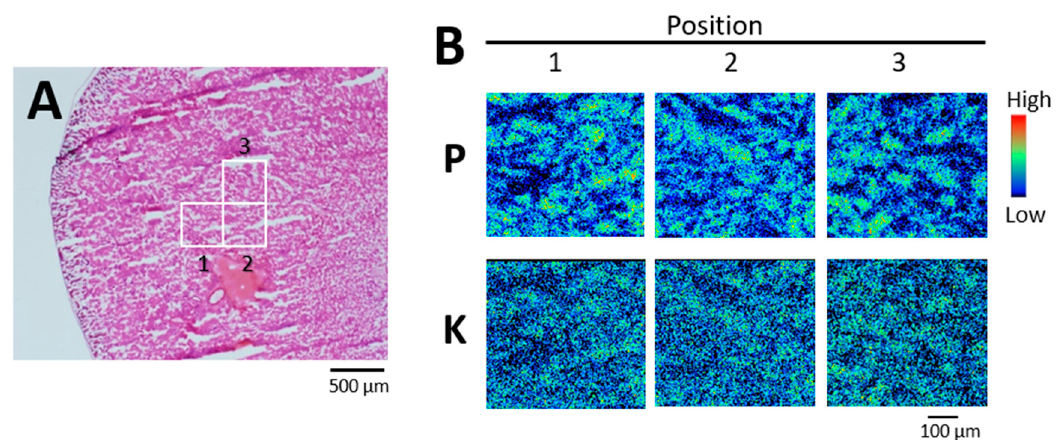
Figure 4. Phosphorus and potassium distribution in kidney on day 1 post-administration of UA (0.5